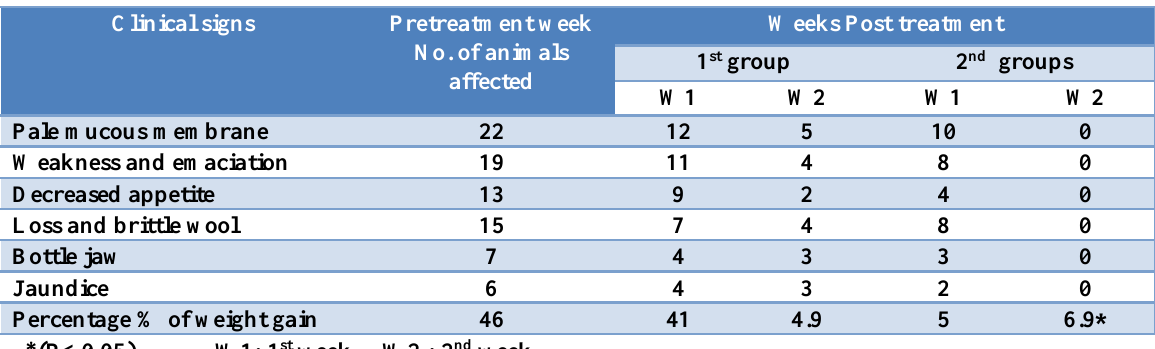
Table,1:Clinical signs in sheep affected with fascioliasis pre and post treatment Clinical signs